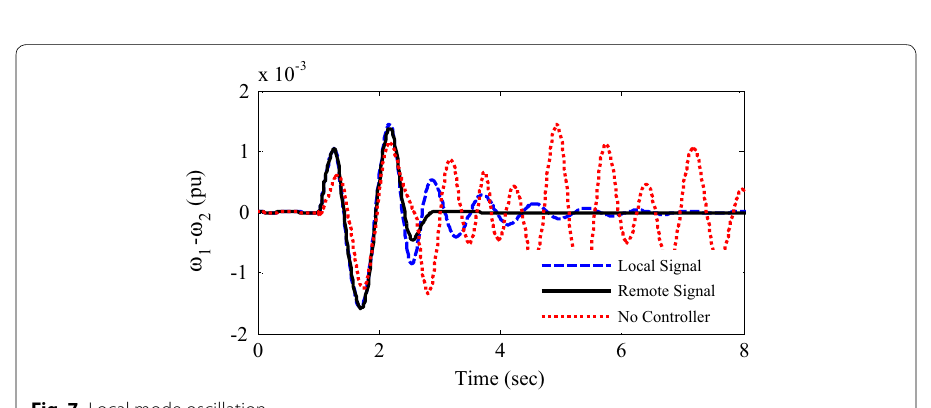
Fig. 7 Local mode